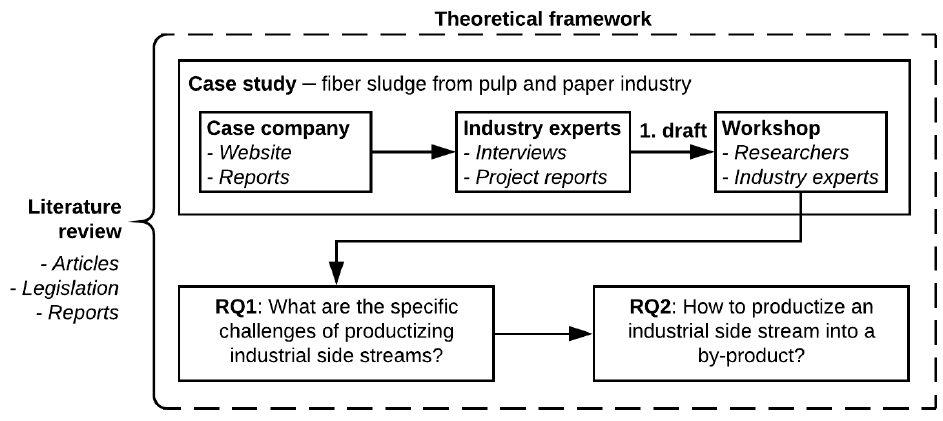
Figure 1. The research process and methods.